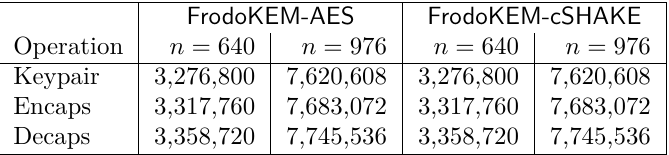
Table 4: Clock cycle counts for our FPGA implementations of FrodoKEM .